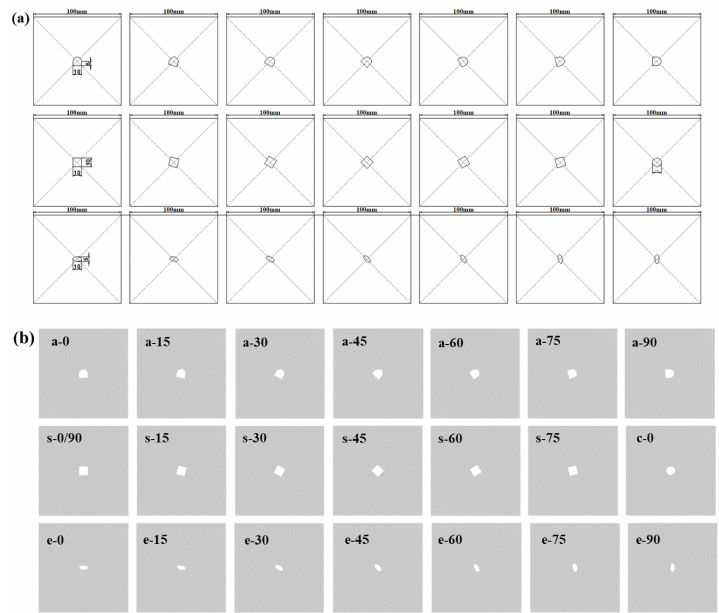
Figure 4. Specimen models with different pre-holes, including ( a ) the size parameters of the pre-holed specimens and ( b ) numerical models of pre-holed specimens with a D-type hole with inclination angles of 0 ◦ (a-0), 15 ◦ (a-15), 30 ◦ (a-30), 45 ◦ (a-45), 60 ◦ (a-60), 75 ◦ (a-75), and 90 ◦ (a-90); a square hole with inclination angles of 0 ◦ (s-0/90), 15 ◦ (s-15), 30 ◦ (s-30), 45 ◦ (s-45), 60 ◦ (s-60), and 75 ◦ (s-75); and a circular hole (c-0), and elliptical hole with inclination angles of 0 ◦ (e-0), 15 ◦ (e-15), 30 ◦ (e-30), 45 ◦ (e-45), 60 ◦ (e-60), 75 ◦ (e-75), and 90 ◦ (e-90).